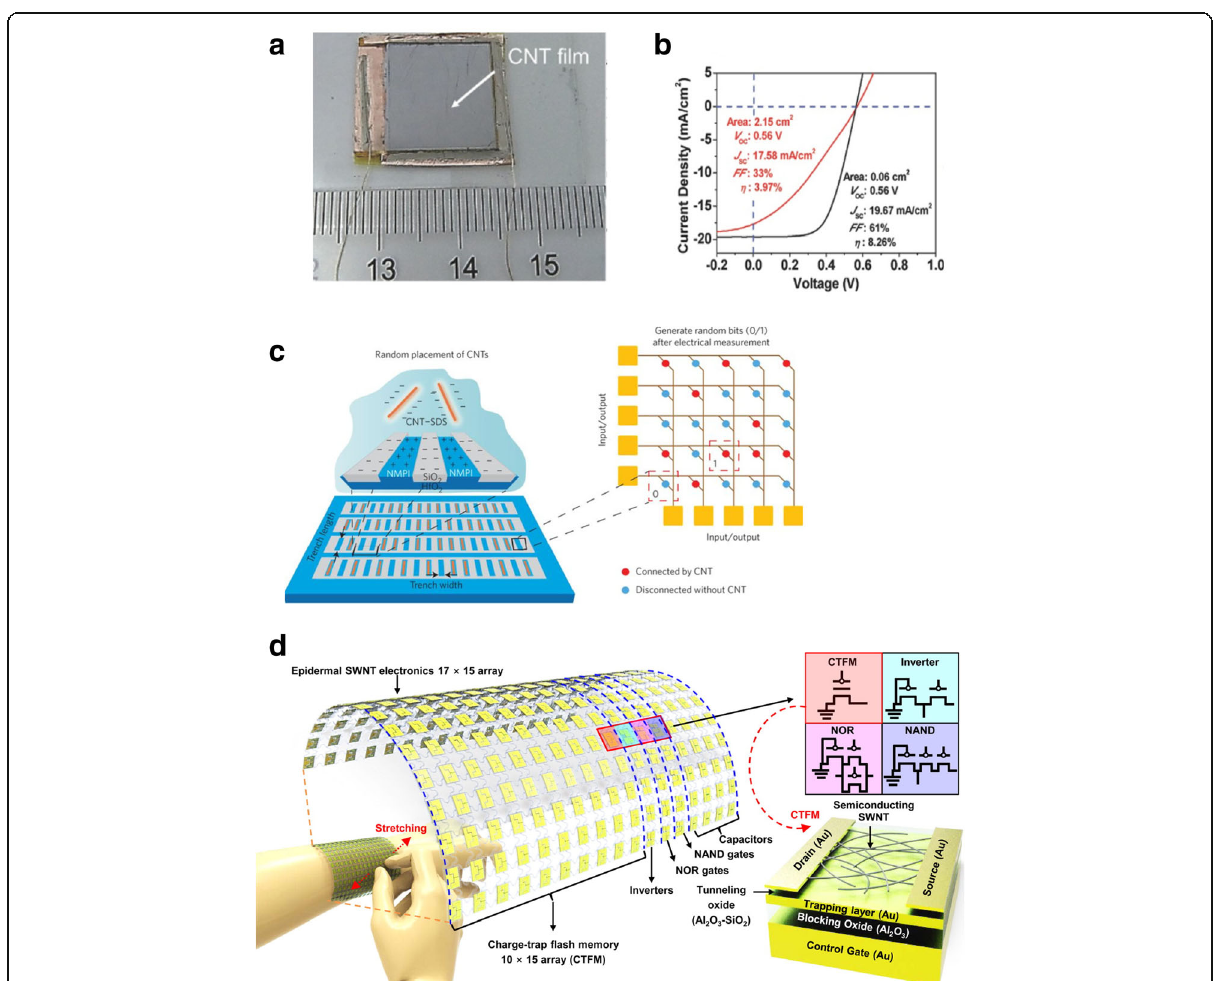
Fig. 46 a Schematic of a thin-film CNT solar cell. Adapted from [308]. b J – V characteristics of a CNT solar cell with area=2.15 cm 2 (in red) and area= 0.06 cm 2 (in black). Adapted from [308]. c Schematic of a randomly connected 2D nanotube array that can be used as a crossbar switch. Here, CNTs self- assemble in the HfO 2 trenches with width of 70 – 300 nm. Adapted from [314]. d Schematic of an s-SWCNT-based wearable array of electronic